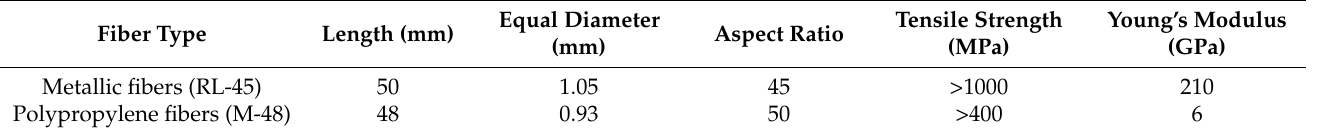
Figure 3. Metallic ( left ) and synthetic ( right ) fibers. Table 2. Properties of fibers.